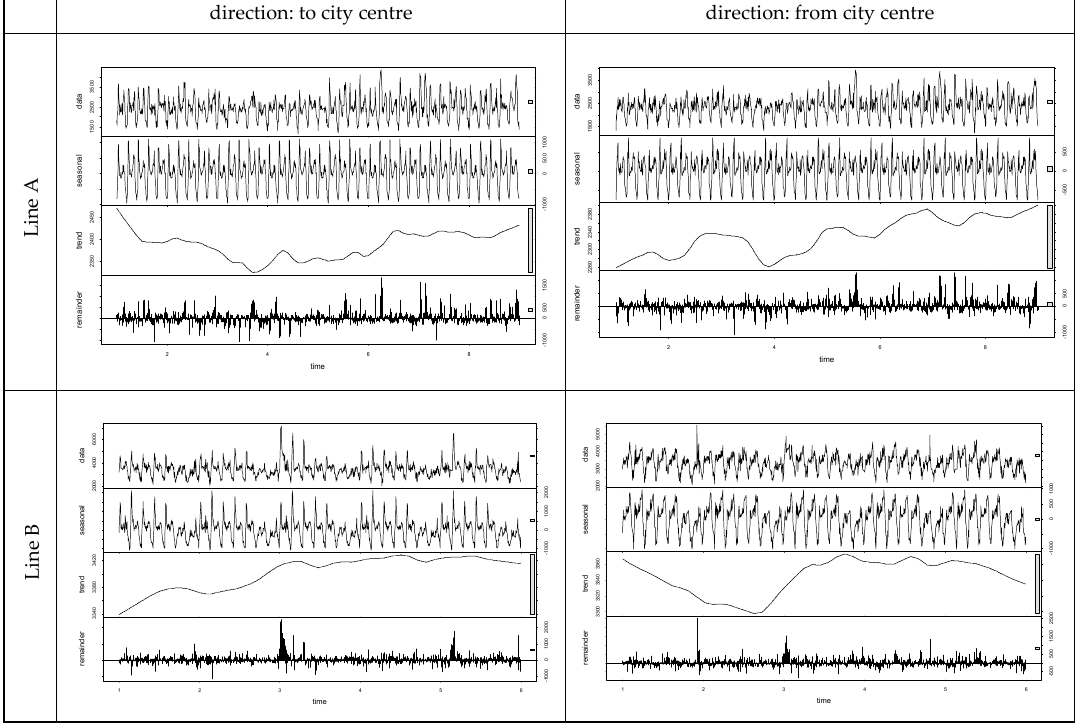
Figure 4. Travel time STL decomposition with weekly period (8 weeks): Rome.